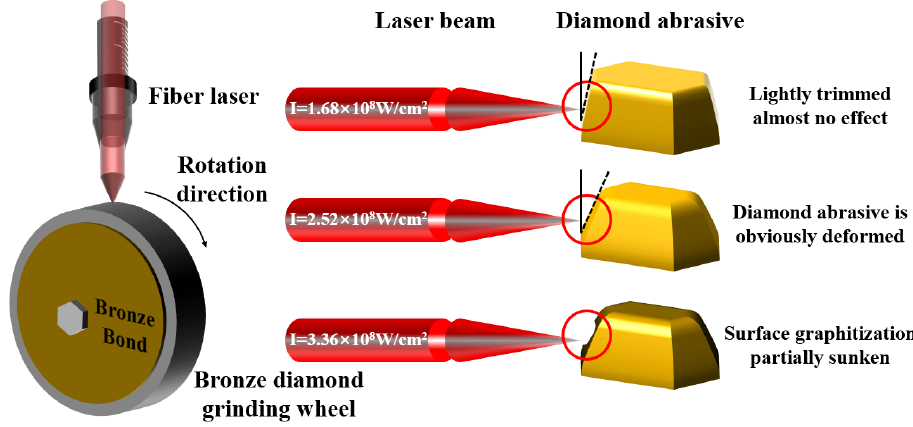
Figure 17. Laser dressing the bronze-bonded diamond abrasive grinding wheel experimental equip-